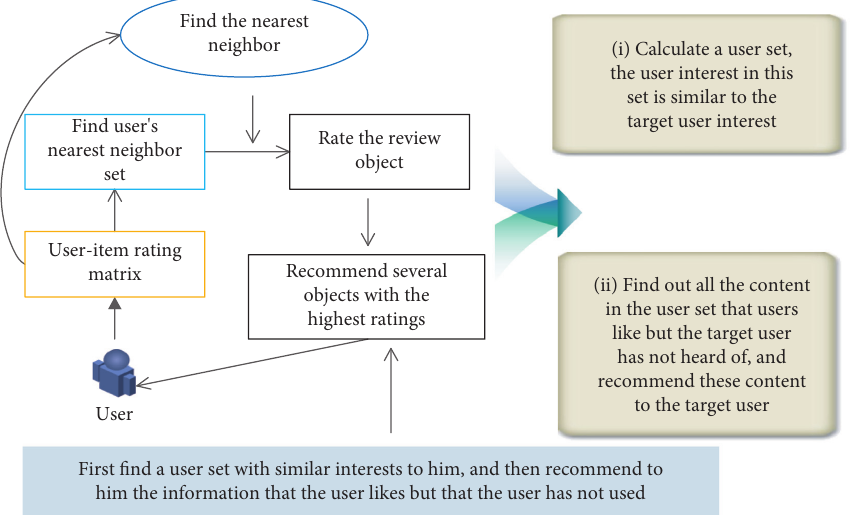
Figure 2: User-based collaborative filtering recommendation